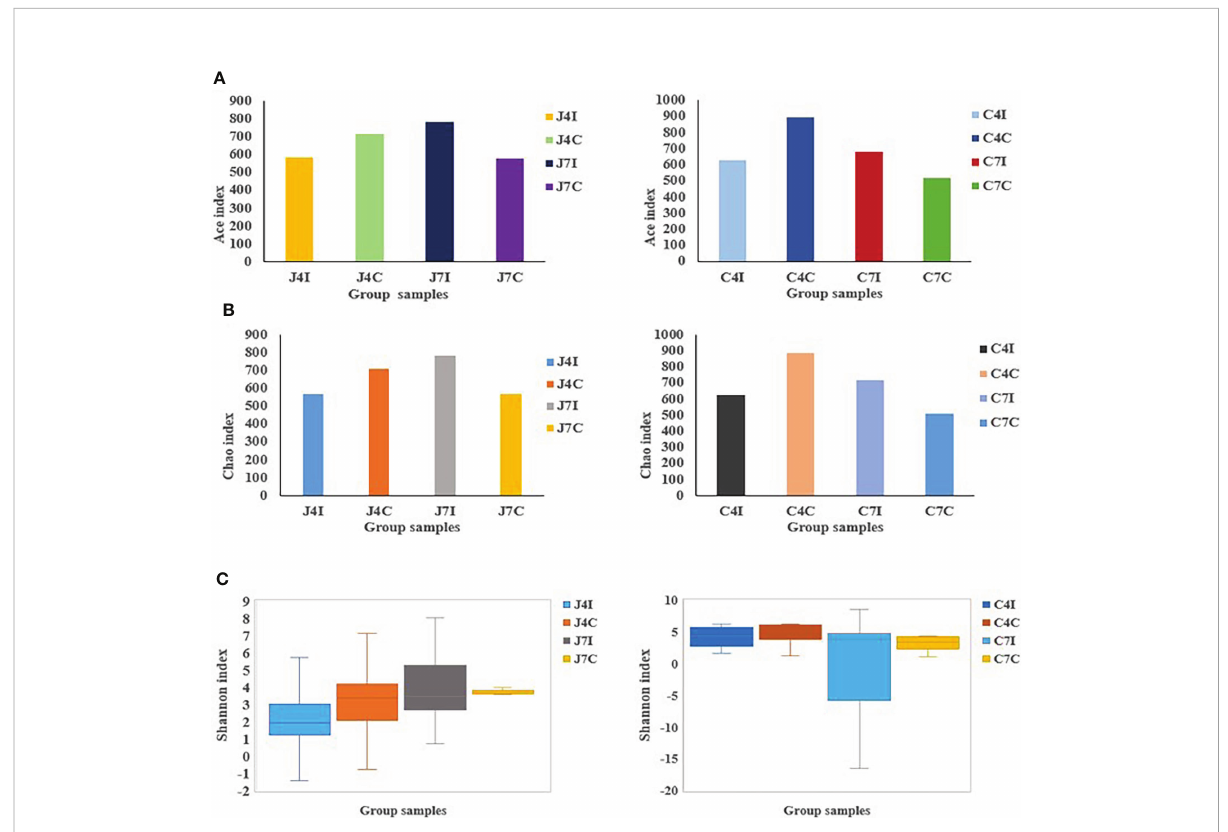
FIGURE 3 OTUs Alpha diversity analysis: (A) Ace index of jejunum and cecum. (B) Chao index of jejunum and cecum. (C) Shannon index analysis of jejunum and